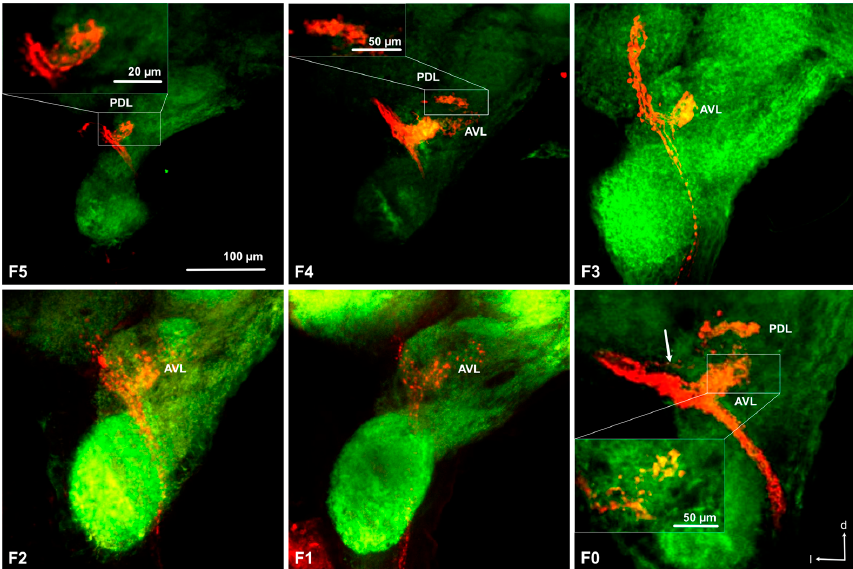
Figure 4. Antennal lobe projections in the 6 investigated nymphal instars of Libellula depressa (F5/F0 instars). Note that all maximum z-projections of stacks of optical sections (over 40 µ m in F5, 32 µ m in F4, 14 µ m in F3, 21 µ m, 28 µ m in in F1 and F0) were taken at the same scale. Insets show a higher magnification of individual optical sections from the respective antennal lobe area. AVL anterior-ventral part of the antennal lobe, PDL posterior dorsal part of the antennal lobe (see [31]). The arrow indicates the weakly stained upper antennal nerve branch innervating the PDL area. d dorsal, l lateral. Microruby stained axons in red and background staining with the anti-synapsin antibody in green. Prominent fibers from the antennal nerve, passing the AL posterior-laterally, project to the gnathal ganglion (Figures 2e, 3, and 5). They innervate the same ipsilateral portion of the central part of the GG in all examined nymphal instars (Figure 5). Only rarely we found a few fibers crossing the midline to the contralateral side in F1 and F0 instars (Figure 5). As for ALs, an overall increase in size